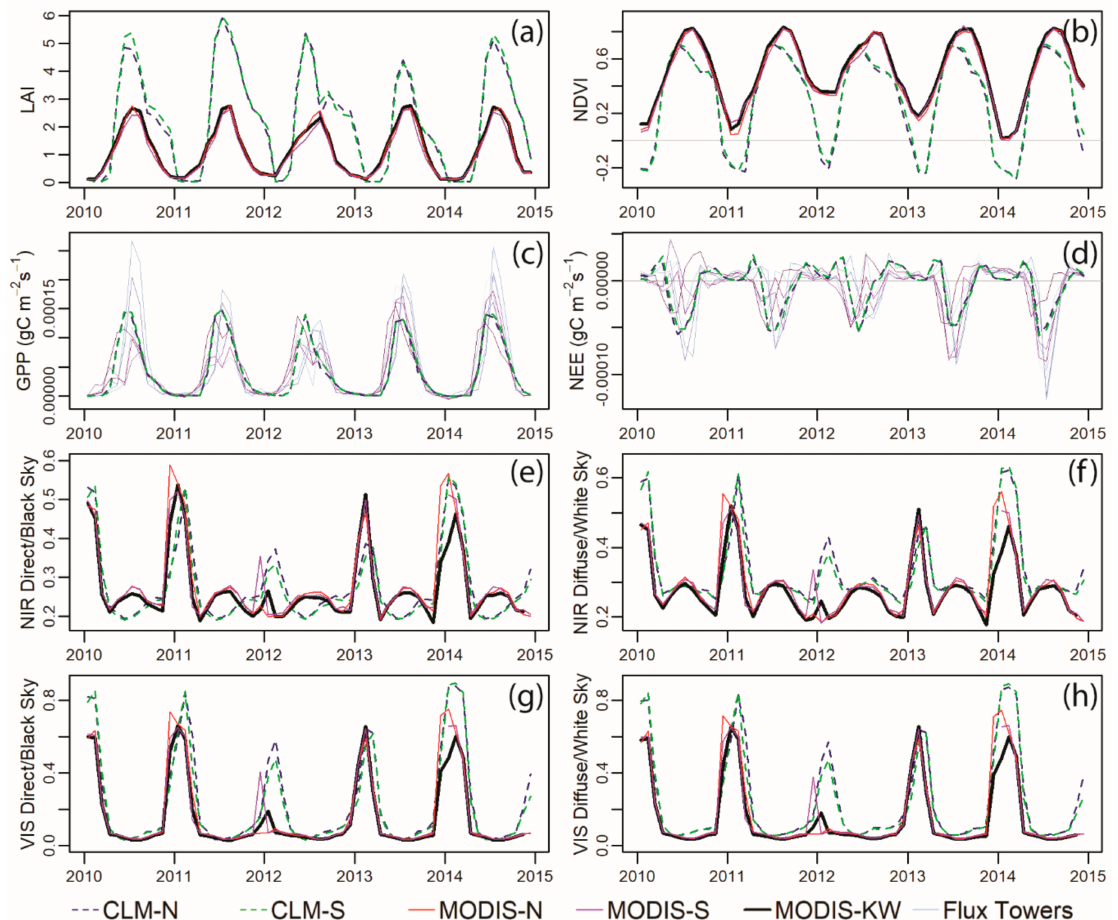
Figure 7. Model output time series compared to observations or satellite products for the five years surrounding 2012 (drought year). ( a ) Leaf area index (LAI); ( b ) NDVI; ( c ) gross primary productivity (GPP); ( d ) net ecosystem exchange (NEE); ( e ) near infrared (NIR) direct or black sky albedo; ( f ) NIR di ff use or white sky albedo; ( g ) visible (VIS) direct or black sky albedo; ( h ) VIS di ff use or white sky